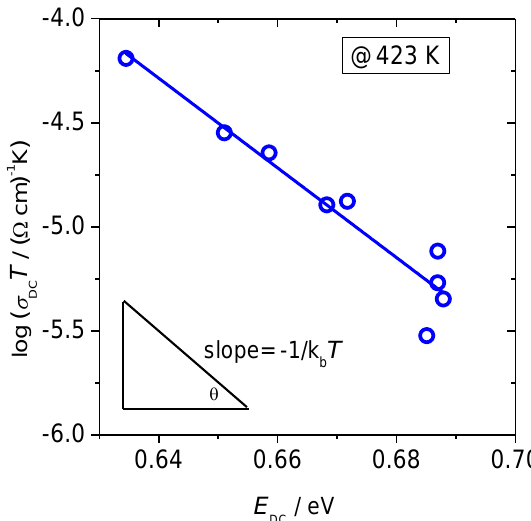
Figure 4. Log( σ DC T ) versus E DC for studied x B 2 O 3 –(100 − x )[40Fe 2 O 3 –60P 2 O 5 ] glass series. Each point represents an individual glass sample. Solid line represents the least-squares linear fit to experimental data.